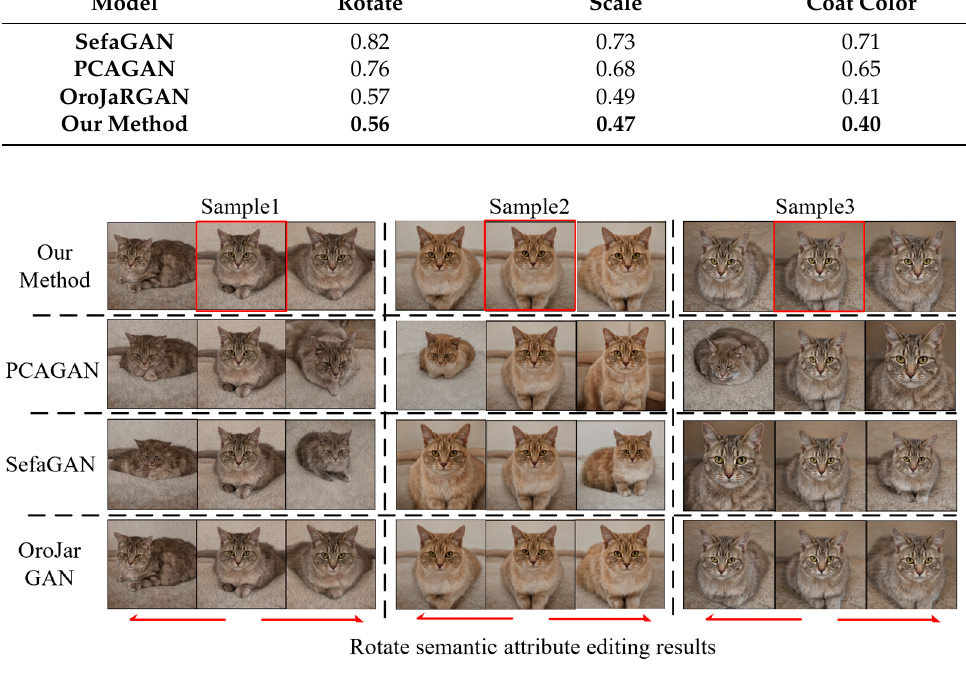
Figure 12. LSUNCat dataset rotates semantic attribute editing comparison results.